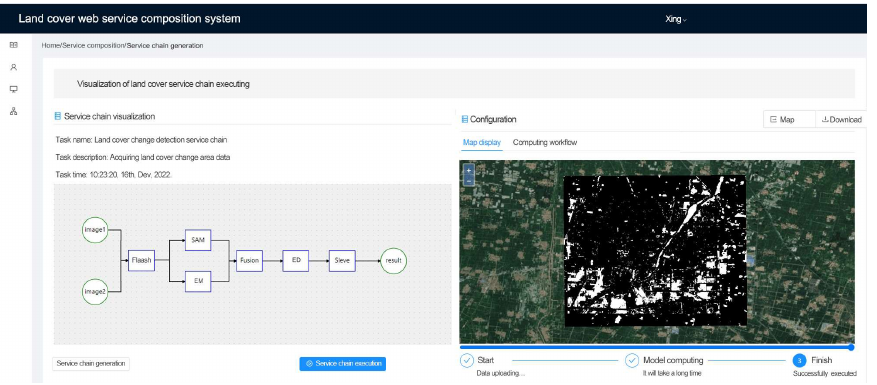
Figure 11. Two generated change detection service chains. ( a ) A service chain based on the con- straint-aware GraphPlan algorithm; ( b ) A service chain bases on the traditional GraphPlan algo- rithm.